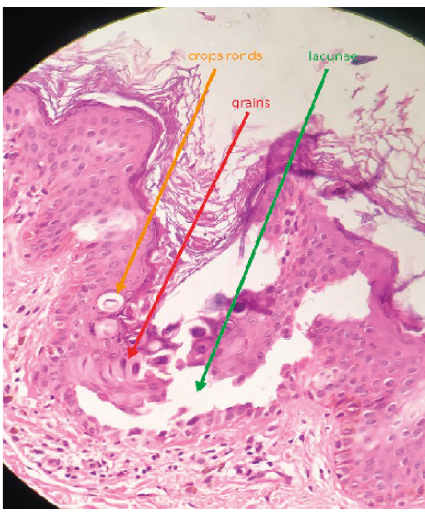
Figure 4: H&E stain with 20 × : acantholysis and dyskeratosis represented by corps ronds and corps grains in DD.